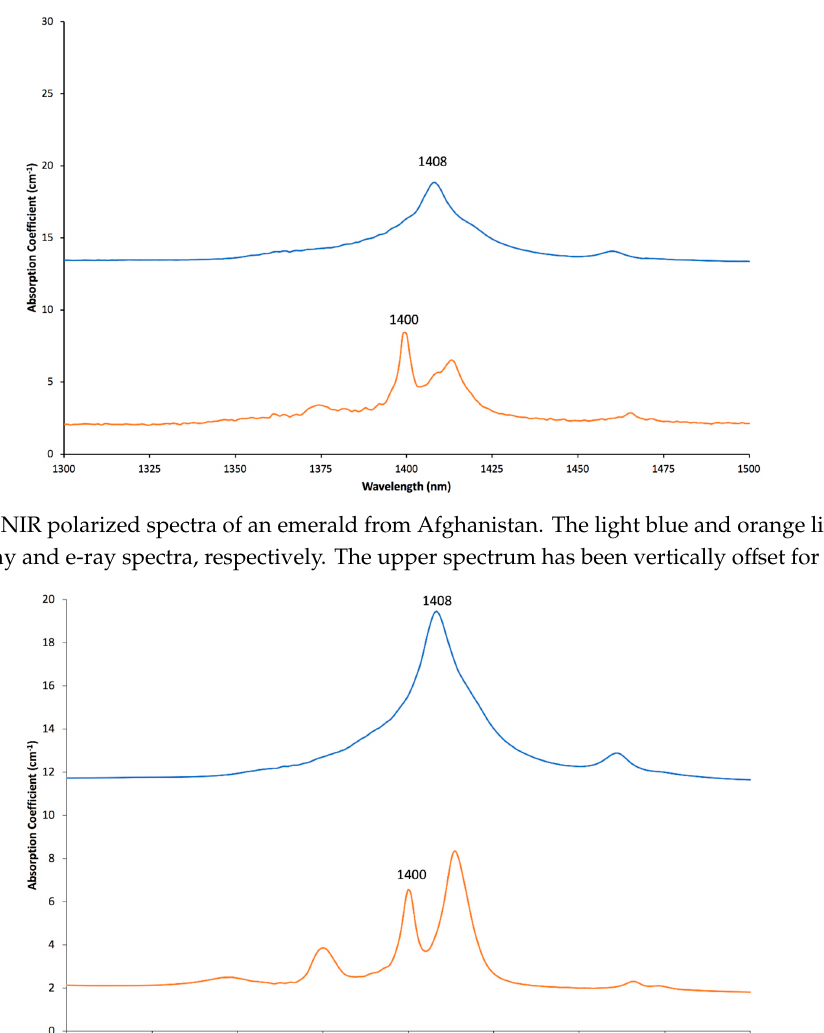
Minerals 2019 , 9 , x FOR PEER REVIEW Figure 16. NIR polarized spectra of an emerald from Colombia. The light blue and orange lines are for the o ‐ ray and e ‐ ray spectra, respectively. The upper spectrum has been vertically offset for clarity.